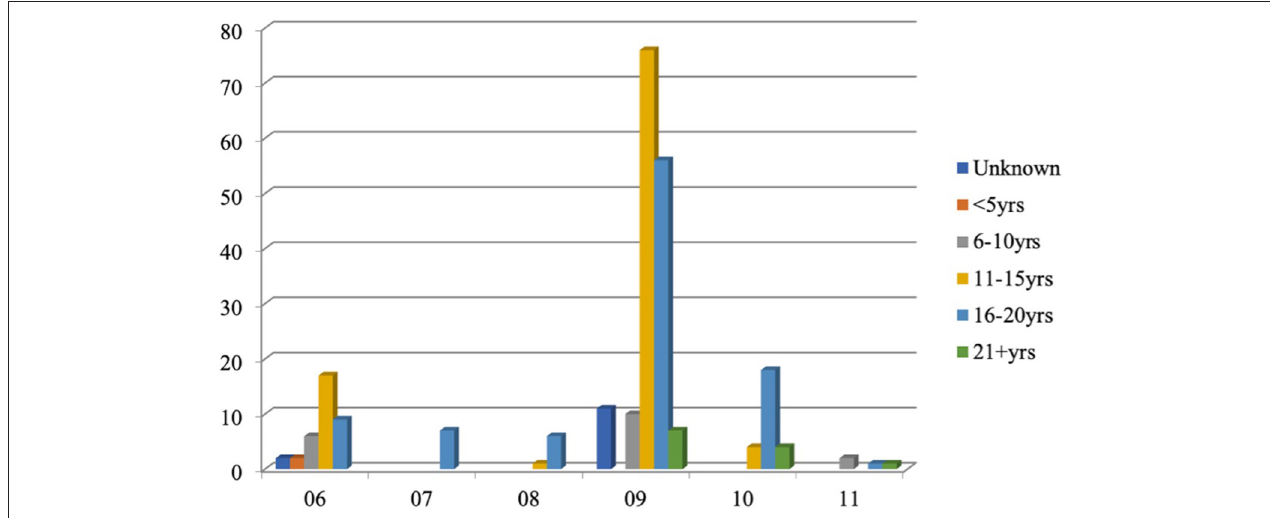
FIGURE 4 | Number of teeth by Triadan position and ages of horses (years) with infundibular caries lesions selected for restoration (left and right sides combined).